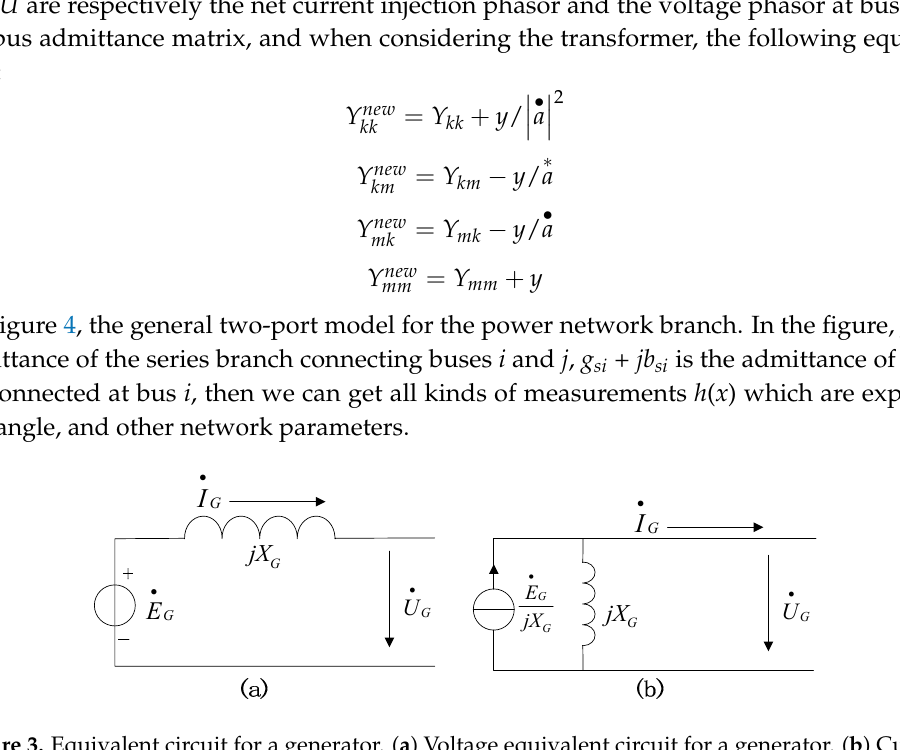
Figure 3. Equivalent circuit for a generator. ( a ) Voltage equivalent circuit for a generator. ( b ) Current equivalent circuit for a generator.